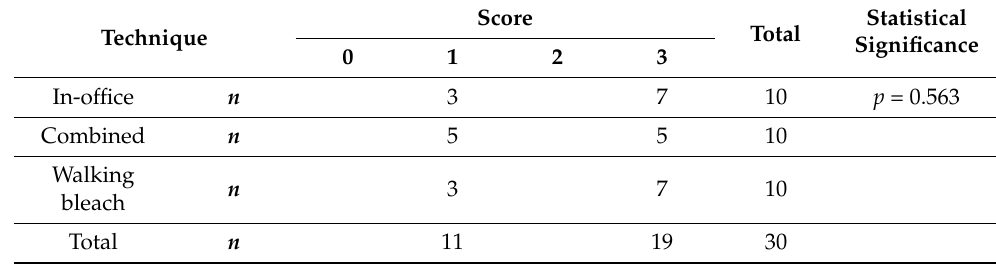
Table 5. Bleaching results depending on the bleaching technique.